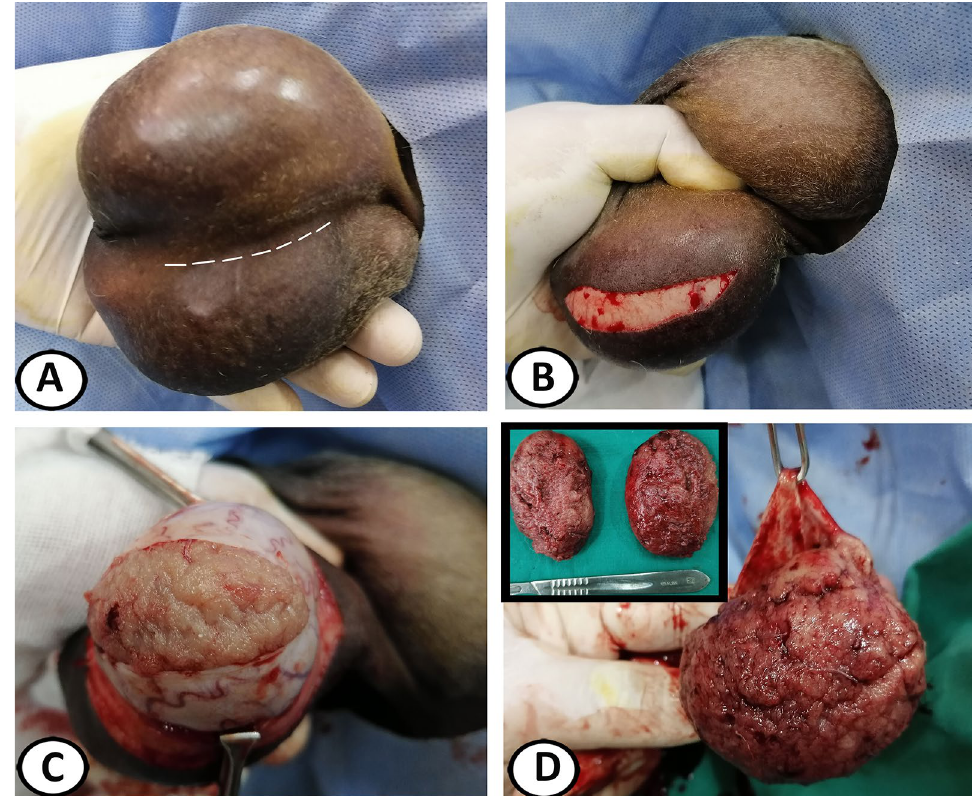
Figure 1. Subcapsular castration (SC) in donkeys. ( A ) Anticipated site of the scrotal incision. ( B ) Incision of the scrotal skin. ( C ) Incision of the dartos fascia, external and internal spermatic fasciae, parietal and visceral vaginal tunics, and tunica albuginea. ( D ) Surgical dissection of the testicular parenchyma. Note, the excised testicular parenchyma (inserted